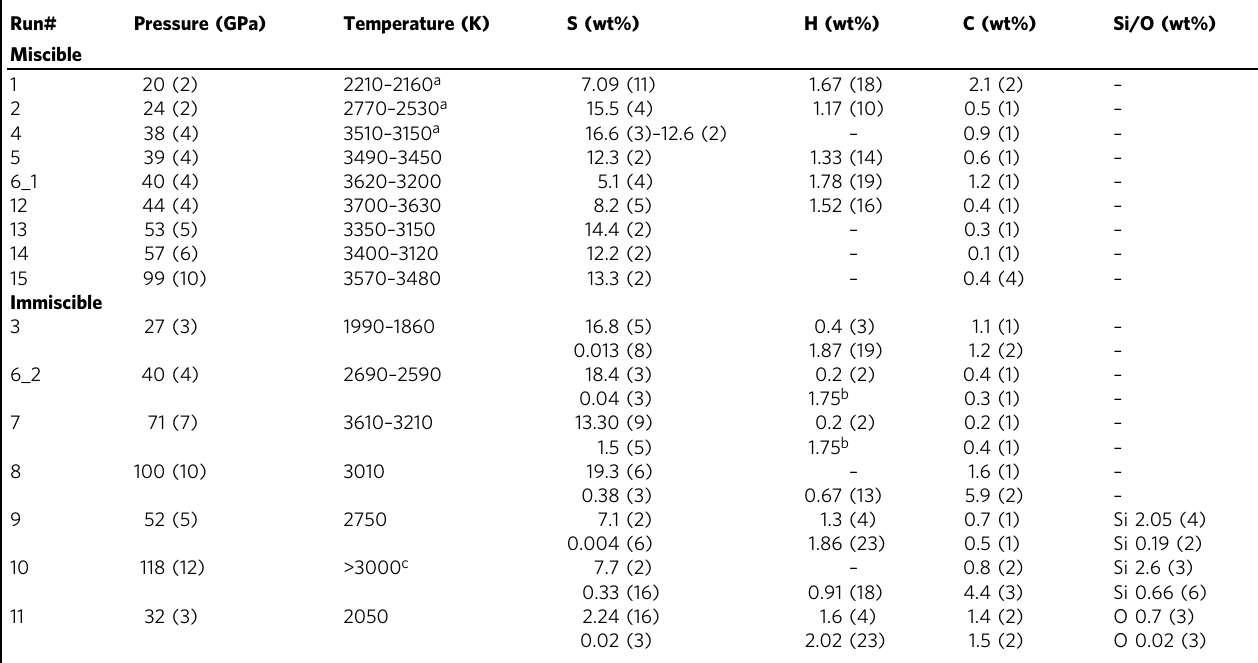
Table 1 Experimental conditions and